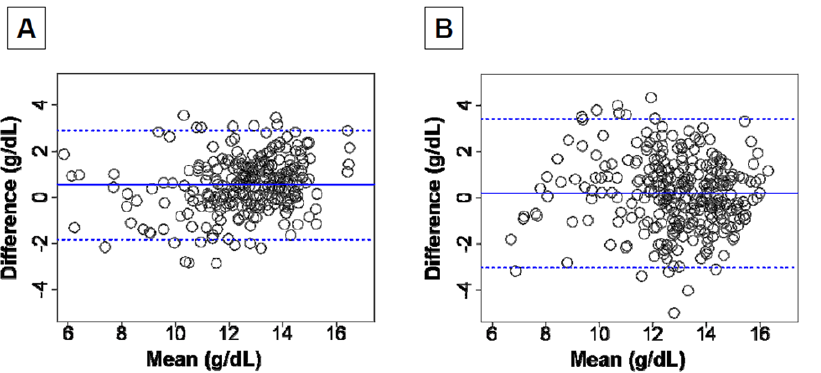
Figure 3. Bland and Altman graphical representation of the concordance between the laboratory value of hemoglobin and SpHb. Results for the Pronto-Study are displayed on the panel A and for the Orsense-Study on the panel B. The plain horizontal blue line represents the mean bias and the dashed horizontal blue lines represent the upper and the lower limits of agreement.